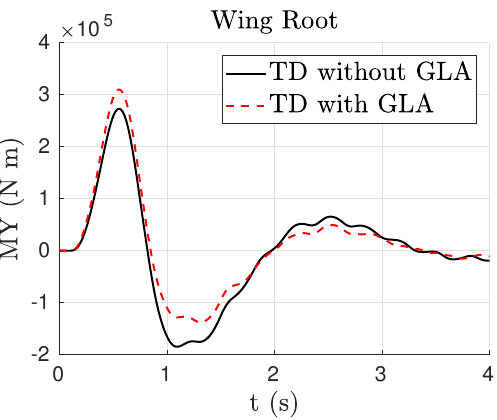
Figure 17. Time history of the incremental torsional moment MY at the wing root with and without GLA